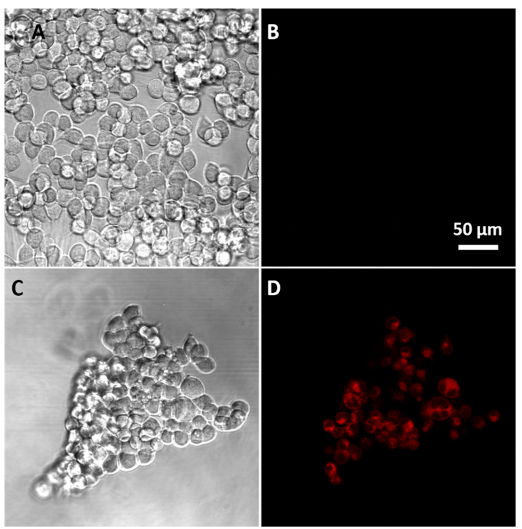
Figure 8. Confocal microscopic images of HEK293 cells ( A ) without the addition of sensor 1 ; (B ) bright-field image of ( A ); ( C ) incubated with sensor 1 (50 μ M) in PBS buffer for 15 min; and, ( D ) bright-field image of ( C ).